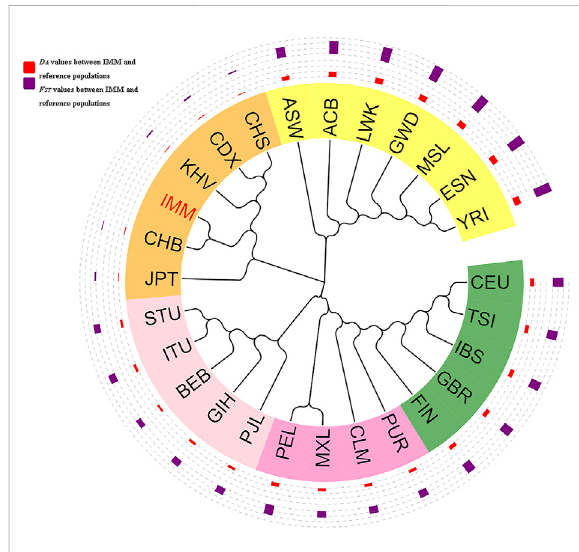
FIGURE 6 Phylogenetic treebasedonthepairwise D A valuesamongthe IMM group and reference populations on basis of 111